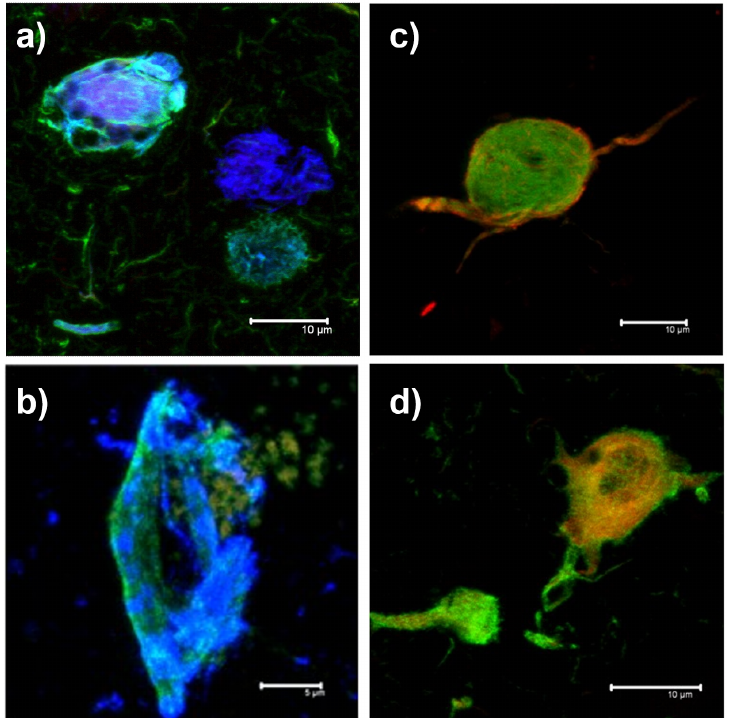
Figure 1. Representative examples of the images obtained by Immunofluorescence for each of the proteinopathies-tauopathies in the hippocampus of the clinical cases included in this study. High magnifications (100 × ) are observed for neurofibrillary tangles for each disease group. ( a ) Alzheimer’s disease; ( b ) progressive supranuclear palsy; ( c ) taEngle only; ( d ) frontotemporal dementia.